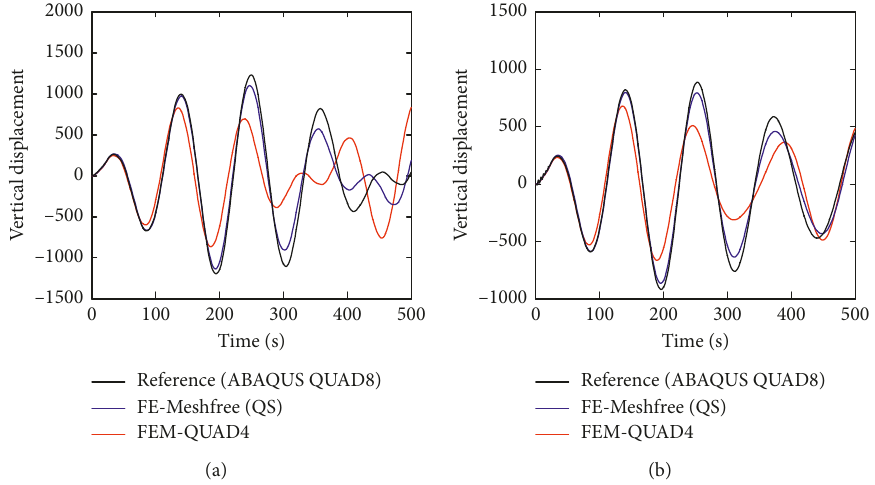
Figure 27: Transient response of cantilever beam subjected to harmonic loading with ω